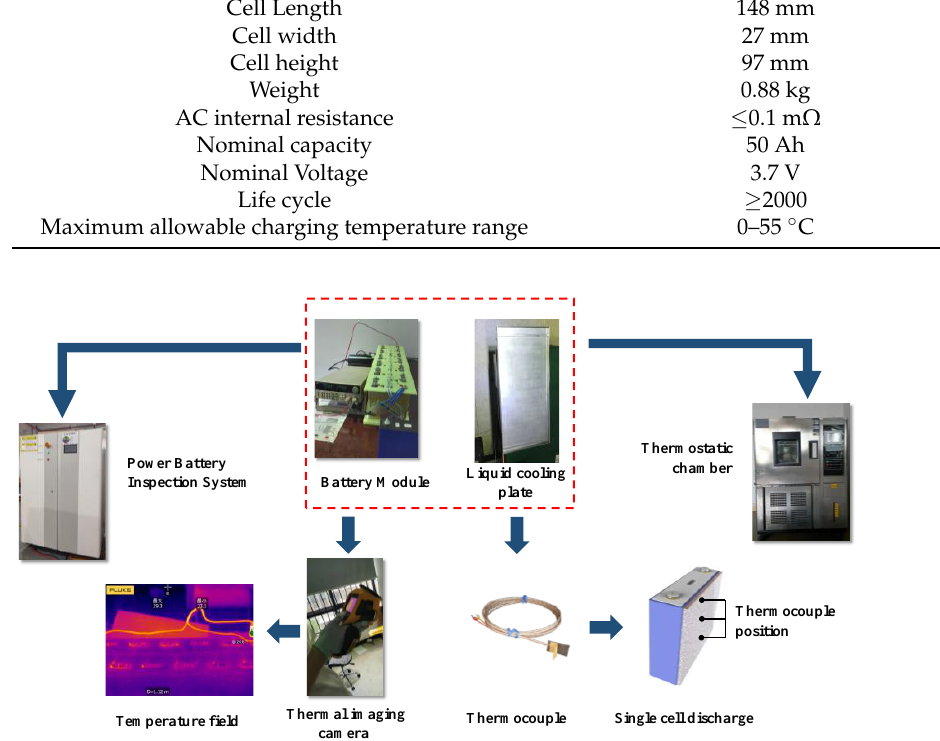
Figure 4. Experimental operation process diagram. Figure 4 . Experimental operation process diagram. Table 2 . Lithium battery parameters.